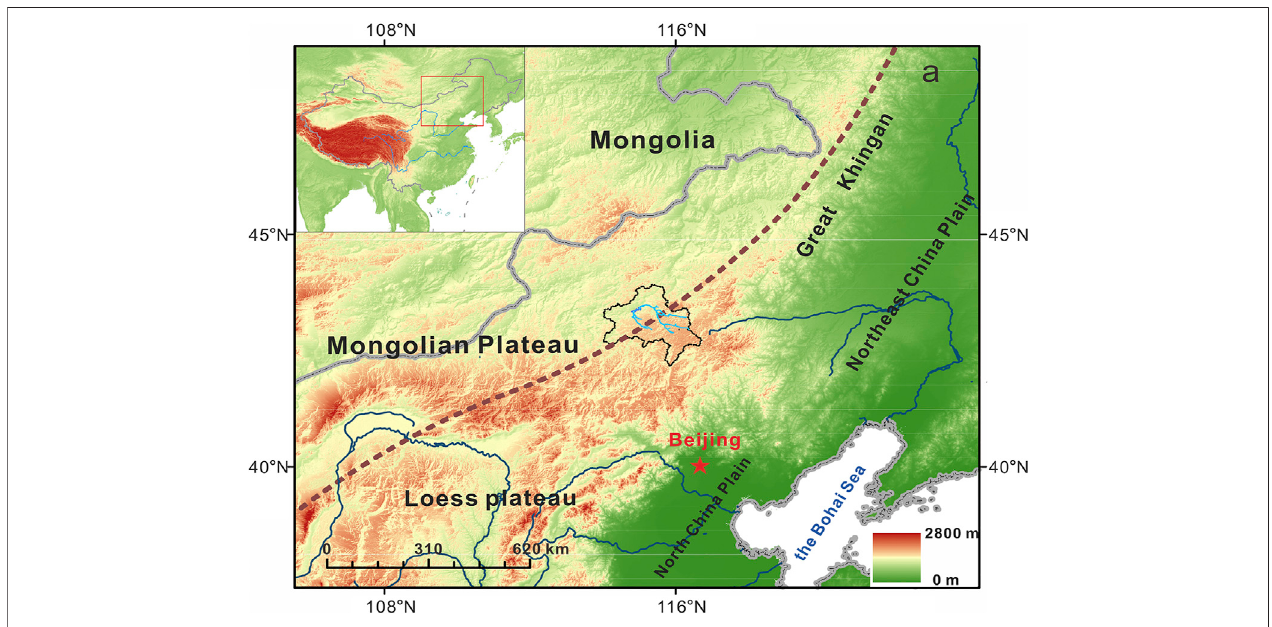
FIGURE 1 | Location of Chagan Nur basin in northern